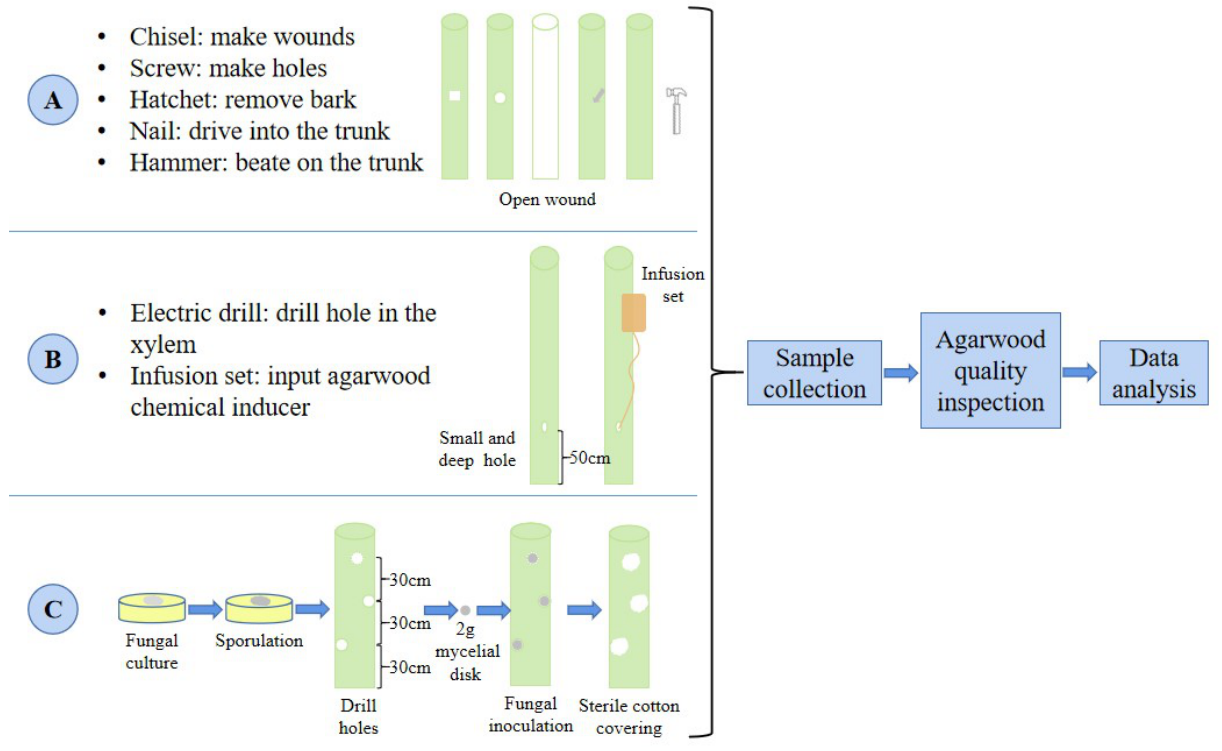
Figure 1. Methods of artificial induction of agarwood resin . A Physical injury [ 38 ] , B Chemical inducer [ 12 ] , C Biological inoculation ( fungal inoculation ) [ 28 ].